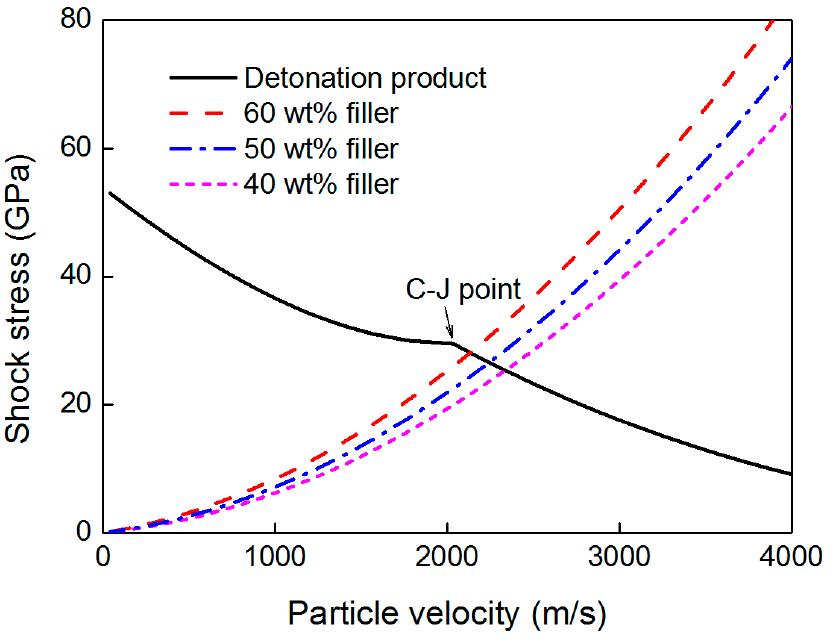
Figure 6. Relationship between pressure and particle velocity for detonation products and cladding materials.